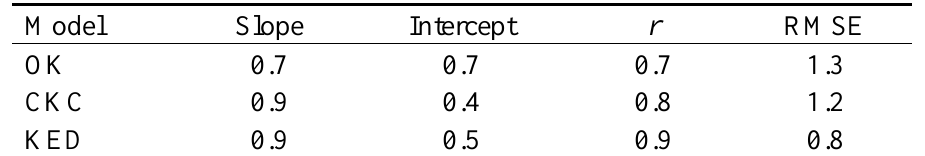
Table 2. Statistics derived between the OK, CKC and KED LAI fields versus LAI estimated from DHP at a significance level of